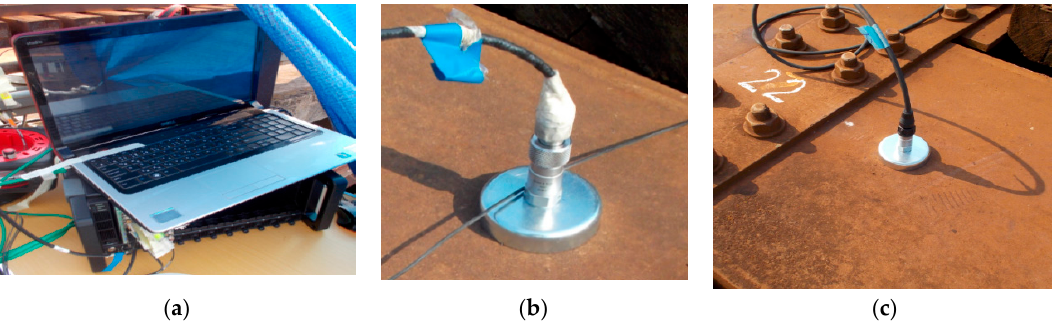
Figure 2. Brüel & Kjær measurement system of dynamic parameters ( a ), piezo-ceramic low frequency ( b ) and less sensitive ( c ) converters for measuring vertical and horizontal fluctuations .